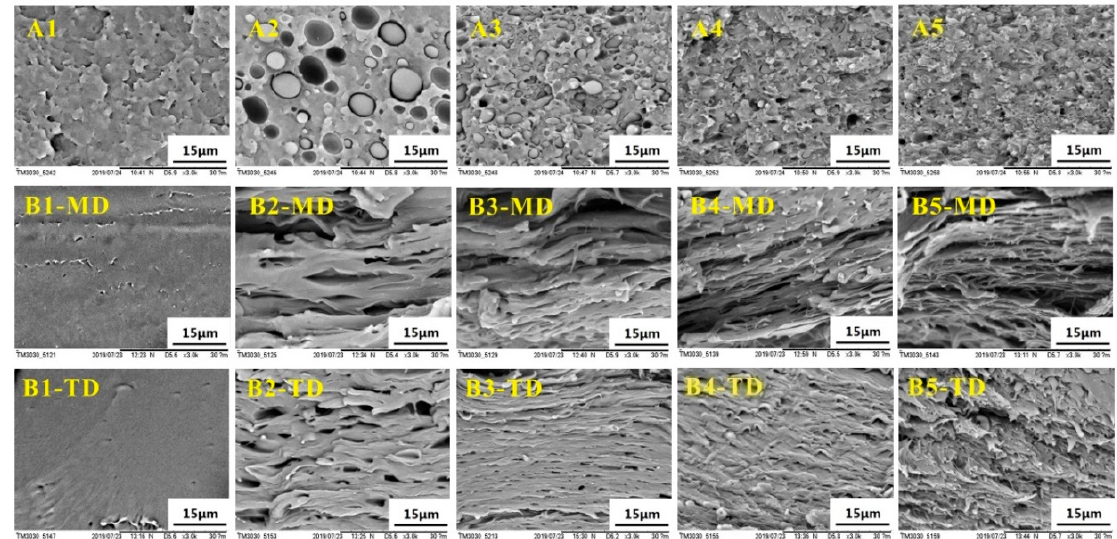
Figure 12. SEM images of annealed PLLA and PLLA / EPDM / OMMT (90 / 10 / x ) samples prepared by ( A ) compression-molding / ( B ) calendering ( 1 -Neat PLLA, 2 -90 / 10, 3 -90 / 10 / 1, 4 -90 / 10 / 2, and 5 -90 / 10 /